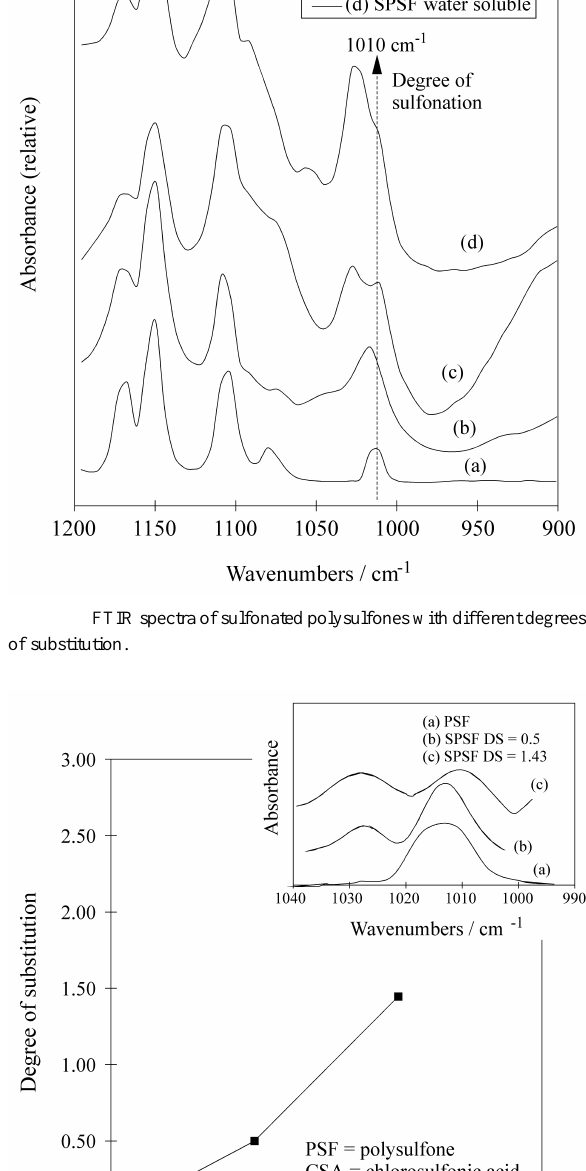
tion. A scheme of the reaction procedure is shown in Fig. 1. The NMR study 24 also demonstrated that the substitution occurs preferentially on the ortho position, in relation to the ether group, of benzene rings at the Bisphenol A unit (Fig. 1).